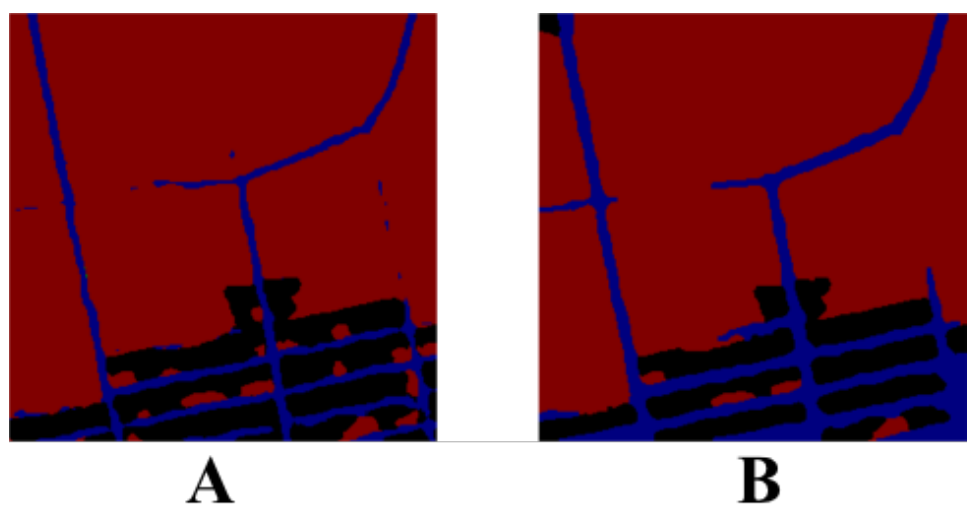
Figure 5. Visualization of the effect of reducing the number of connected domains. ( A ) Initial seg- mentation result of roads; ( B ) Optimized segmentation result after applying morphology processes.